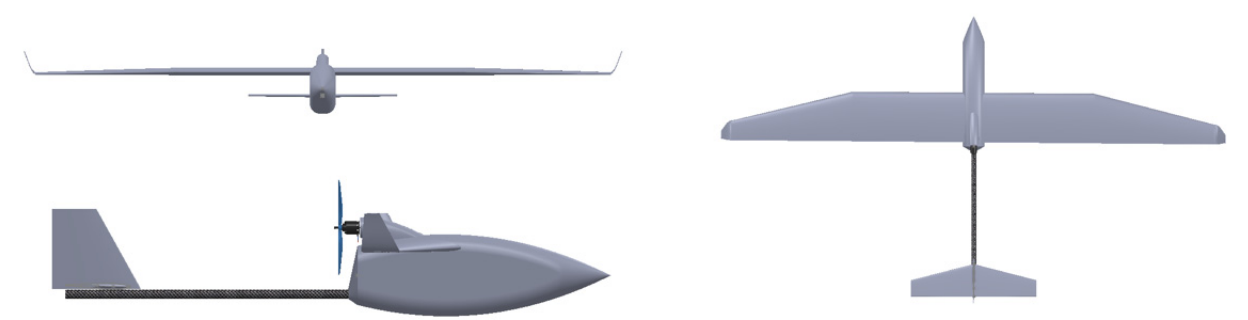
Figure 2. 3-view of the Euclid Small UAV.